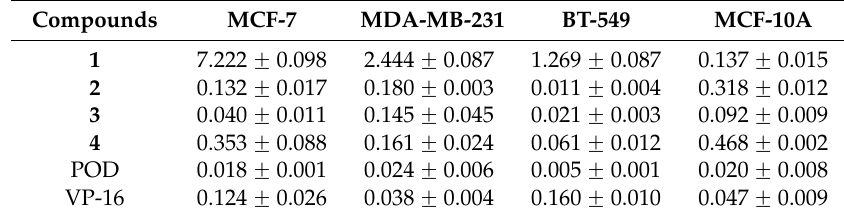
Table 1. Cytotoxic activity (IC 50 µ M) of lignans. IC 50 values are mean of three independent experiments ˘ S.D.